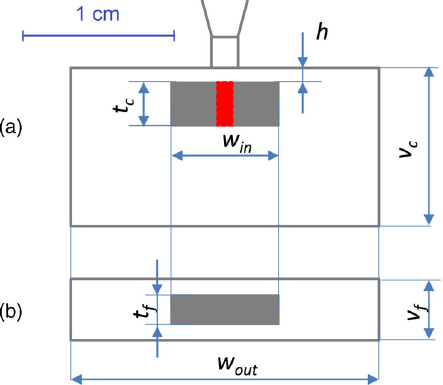
FIG. 3. Two cross-sections of the stripline-loop: (a) plane xz across the cathode, (b) plane xy across the feeding stripline. The gray rectangular areas represent the inner conductor of the stripline-loop (upper plot) and the feeding stripline (bottom plot). The cathode is shown by the red rectangle. In the feeding stripline the position of the inner conductor is symmetrical whereas in the stripline-loop the inner conductor is displaced in order to provide a higher voltage in the cathode – gate-electrode gap.